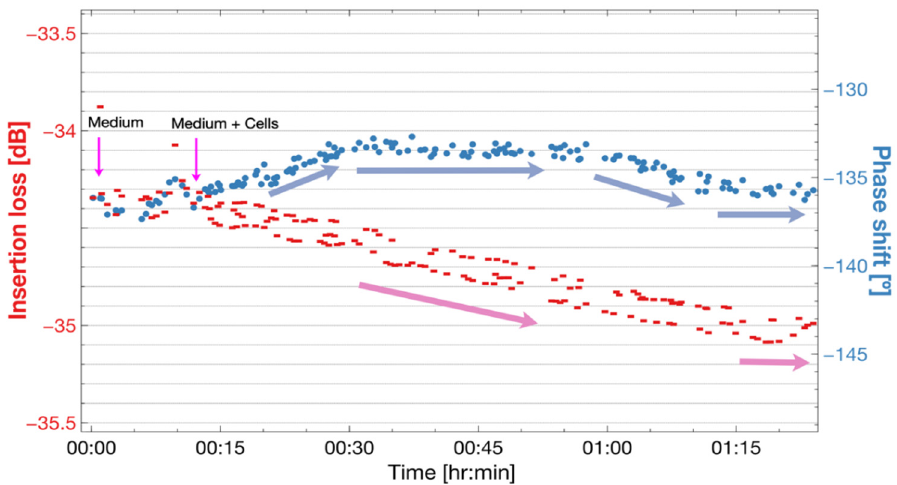
Figure 11. Experimental insertion loss and phase response of the Love wave sensor under changes of 1 mL of cell culture medium with SaOs − 2 cells. Once the use of solution with cells commenced, an increase in the insertion losses was observed and an initial positive shift in the phase flipped to a negative shift.